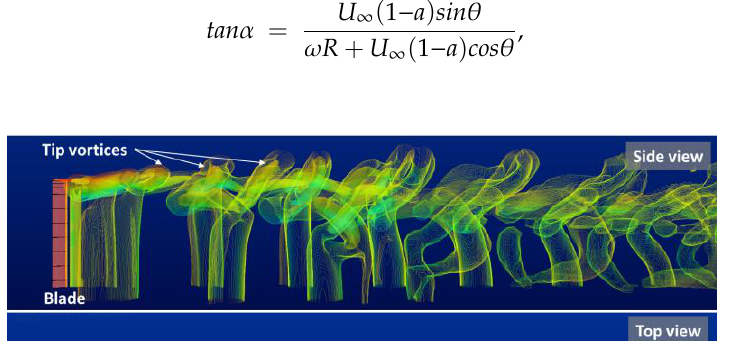
Figure 13. Geometrical relationship between angle of attack and blade azimuth.  is the azimuthal angle,  is the angle of attack, a is the axial induction factor.